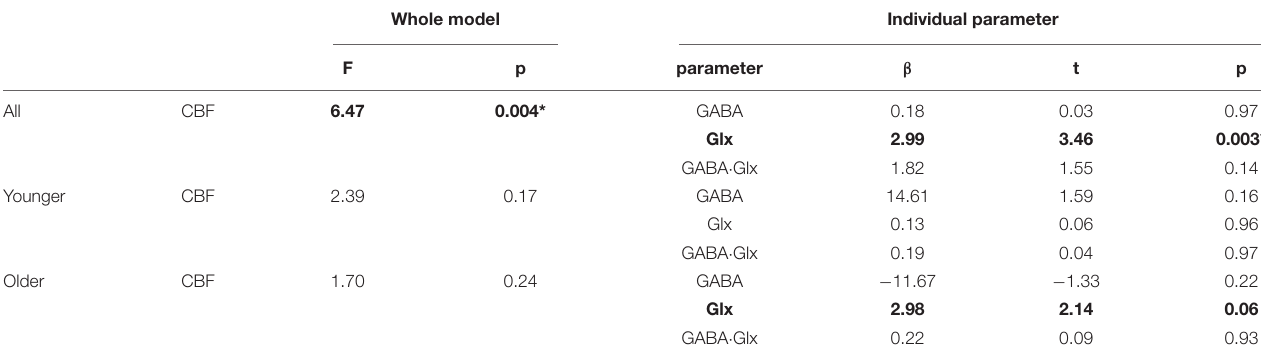
Whole model Individual parameter F p parameter β t